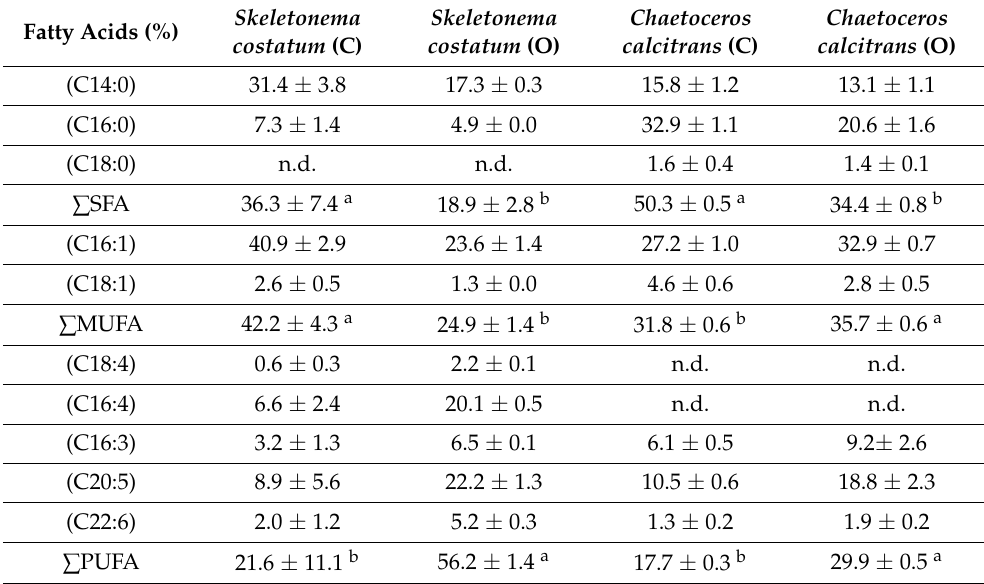
Table 4. Fatty acid profiles of S. costatum and C. calcitrans from the control (C) and optimised (O) trials ( n = 3). The values are expressed as the mean of total FAME percentages ± standard deviation. Skeletonema Fatty Acids (%) costatum (C)